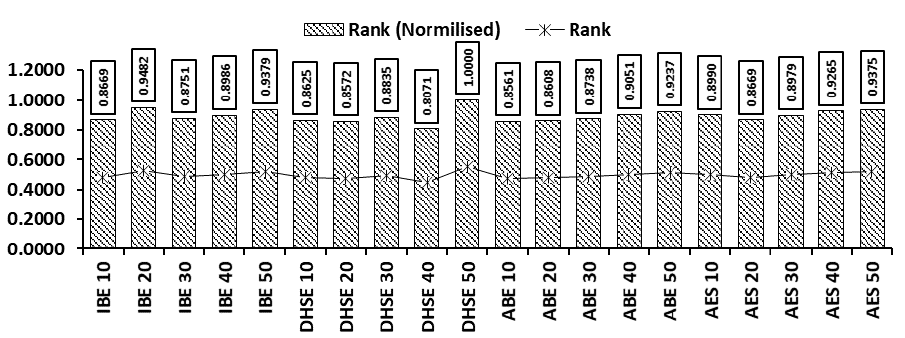
Figure 12. Ranking of encryption